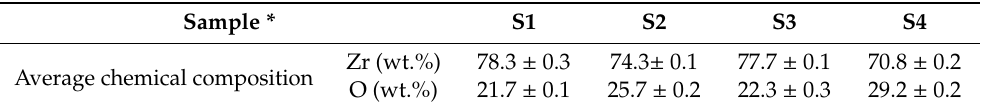
Table 3. Average elemental compositions obtained by energy dispersive X-ray spectroscopy analysis for the coated alloys.